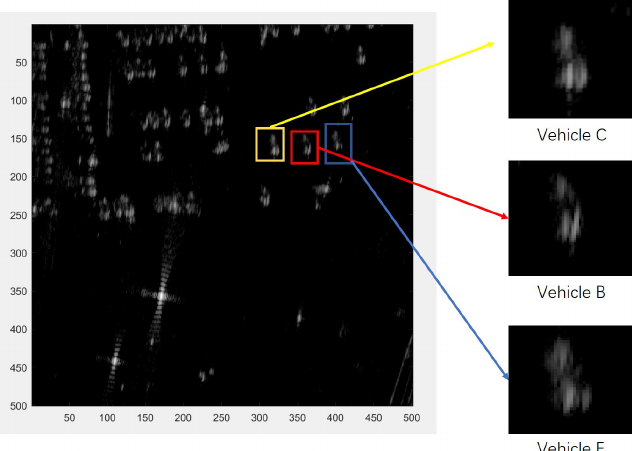
Figure 7. Sparse portion of certain 10 ◦ sub-aperture images after RPCA are non-coherently accumulated.